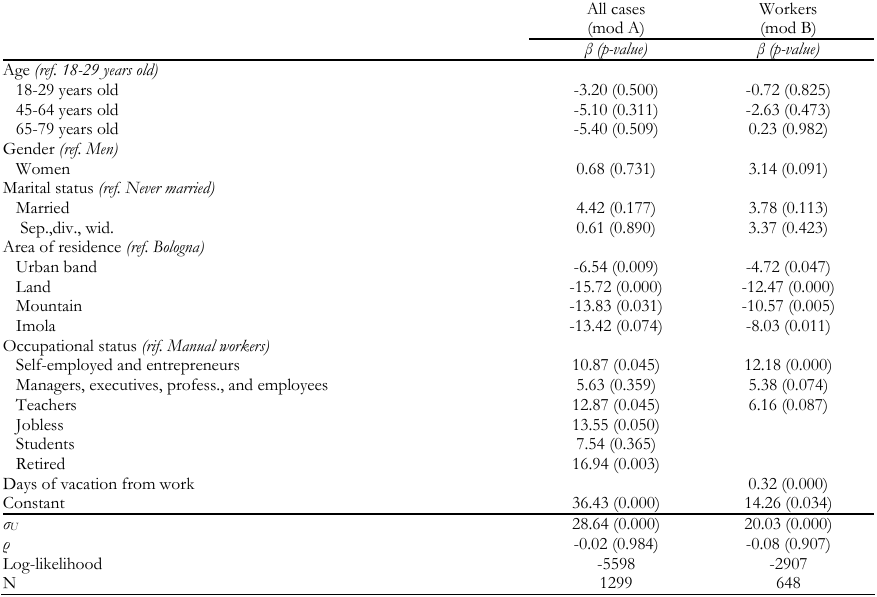
Heckman models: total number of days spent on (long) holidays during 2003-2004 and according to sociodemographic